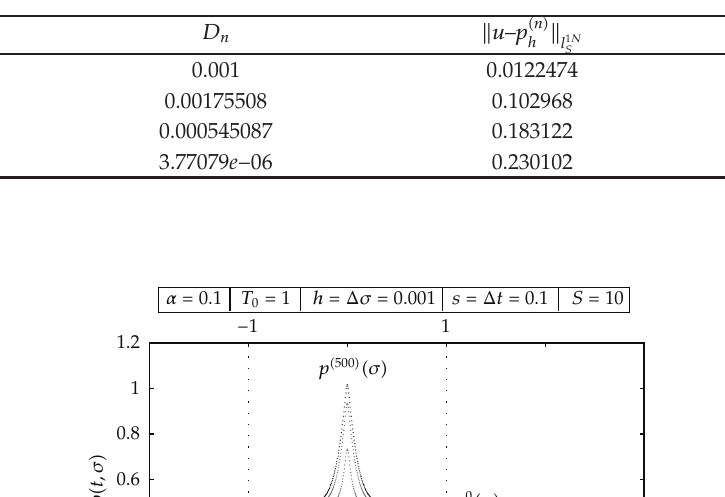
Table 11: Numerical results: Unstable fixed point.